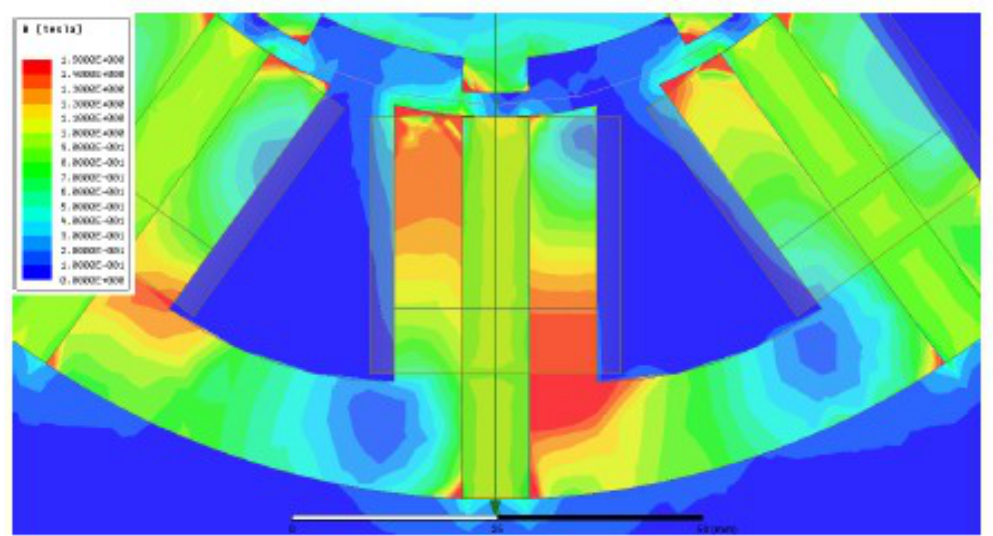
Figure 6. Part of the FSPM with its magnetic flux